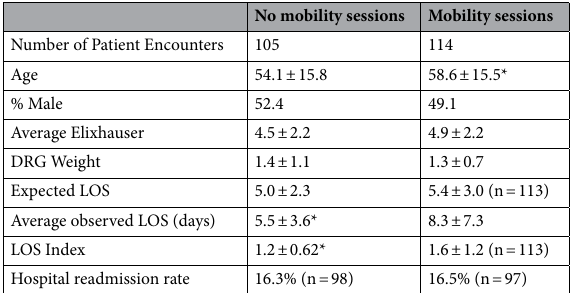
Table. 3. Treatment subgroup results (Group 3). *statistically significant at p < 0.05.